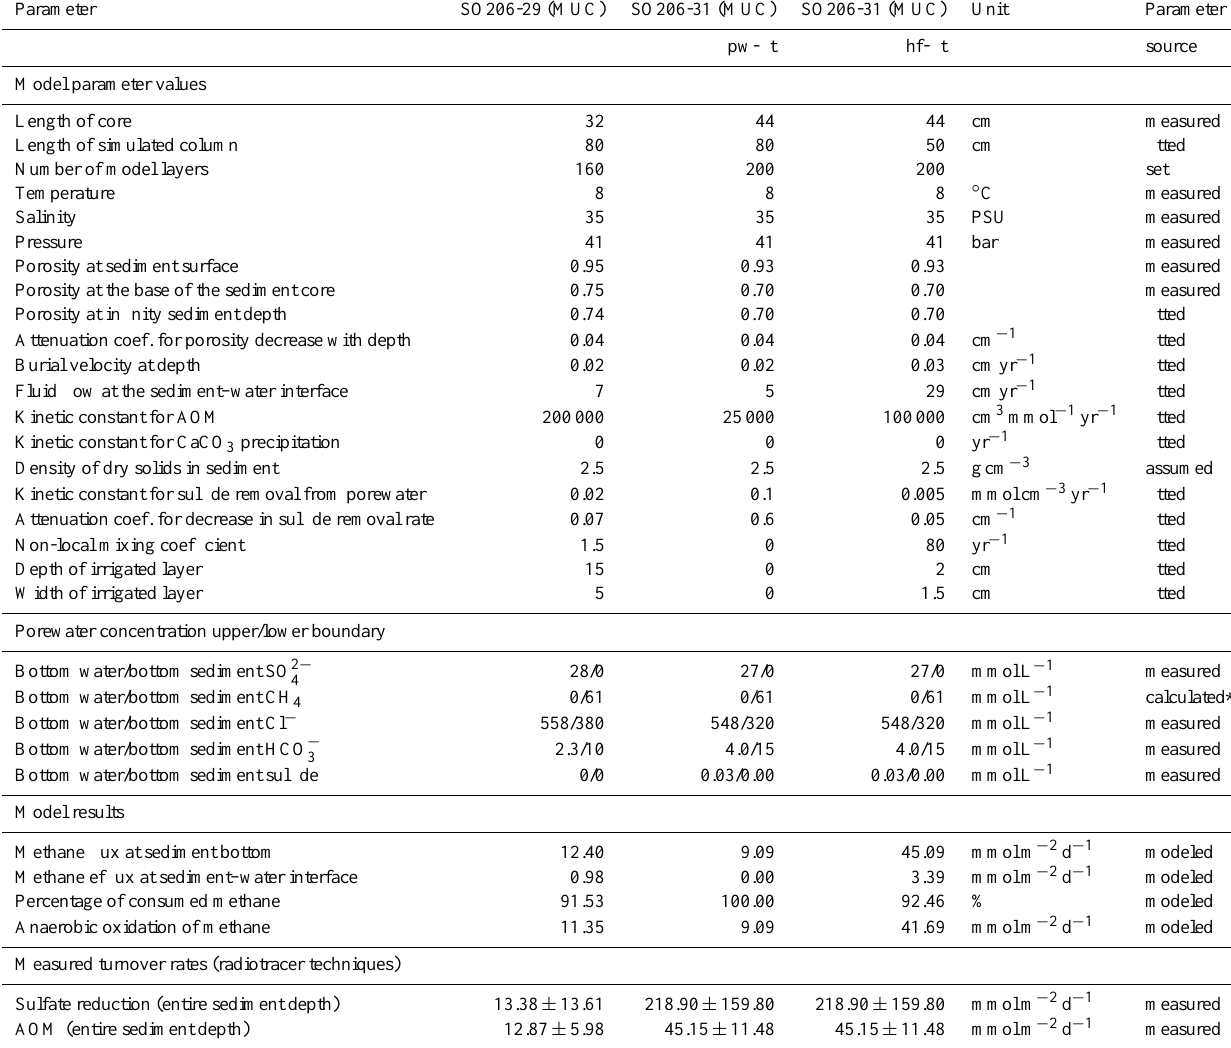
Table 2. Summary of input parameters used for the model simulations and major model results. For the SO206-31 (MUC) cores, two fits are provided, since the replicate core for porewater determinations (pw-fit) exhibited a lower fluid flow and deeper SMTZ than the core used for rate determinations (hf-fit), probably as a result of high fluid flow heterogeneity at the site (see discussion). For more model details, see Krause et al.